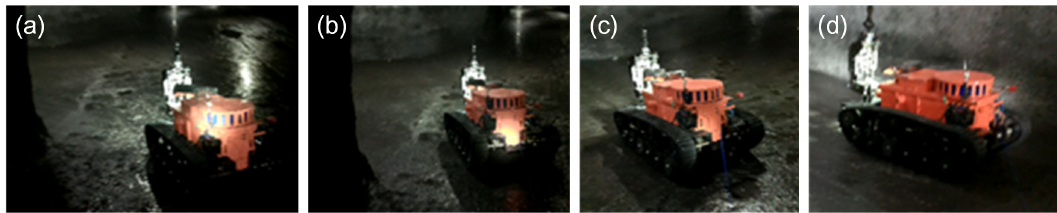
Figure 28. ( a – d ) show that a robot is turning left at a corner under the semiautomatic control mode with the v f – ∆ θ f – R method.